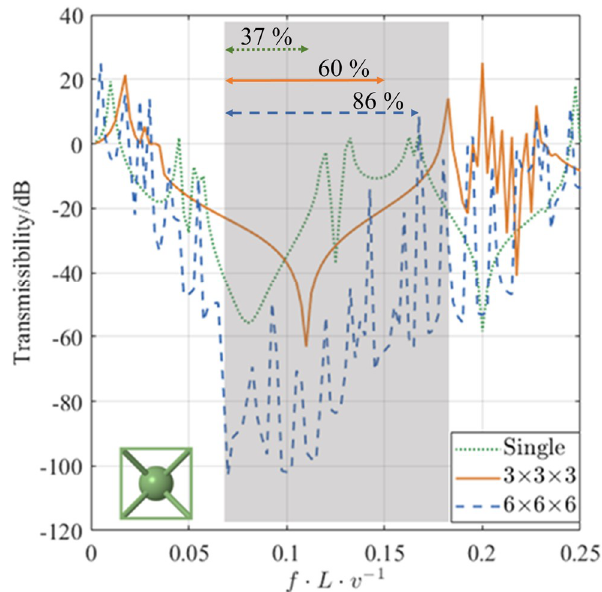
Figure 14. Transmissibility of longitudinal waves in 20% volume fraction res-BCC xyz lattices of finite periodicity. The shaded area represents the BG region as depicted by the DCs with infinite periodicity assumptions. The percentage values denote the bandwidth of the finite lattice to that of the infinite one. Table 6. Summary of the evolution of the BG as obtained from studying the transmissibility of longitudinal waves in BG lattices of different periodicity.